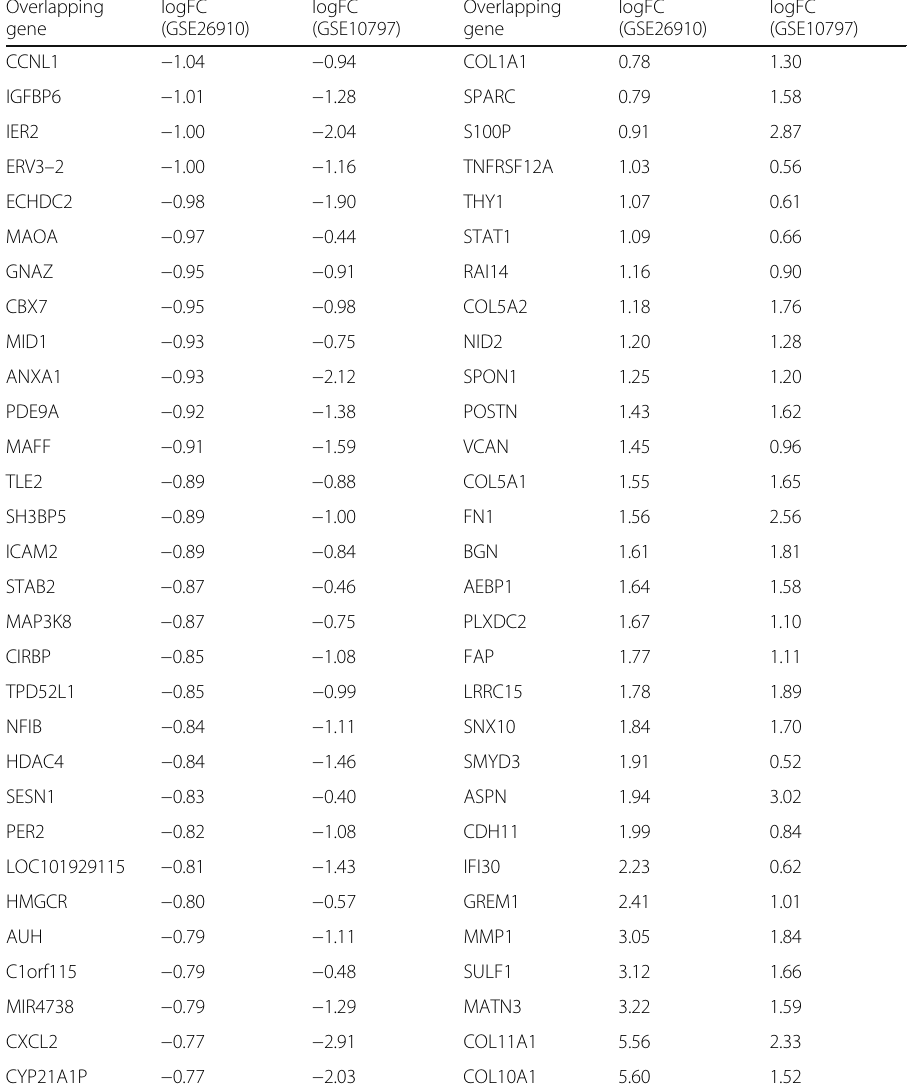
Table 1 The common genes altered in both the GSE26910 and GSE10797 datasets (Continued) Overlapping